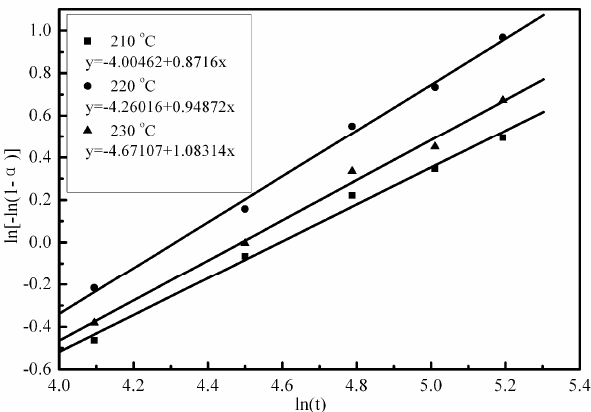
Figure 10. Kinetic plots obtained using the Avrami–Erofeev equation at 210, 220, and 230 °C. Table 3. Reaction kinetics calculated using data acquired at 210, 220, and 230 °C.